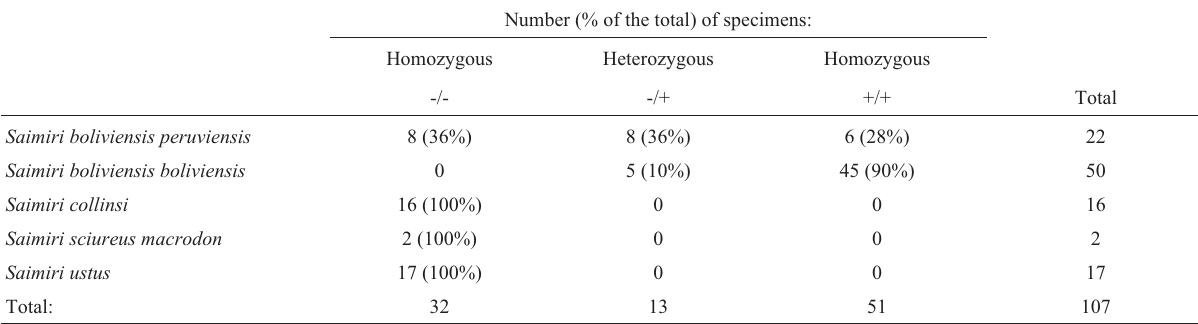
Table 2 - Presence (+) or absence (-) of the Alu TA15 insertion in the Saimiri specimens analyzed in the present study. Number (% of the total) of specimens: